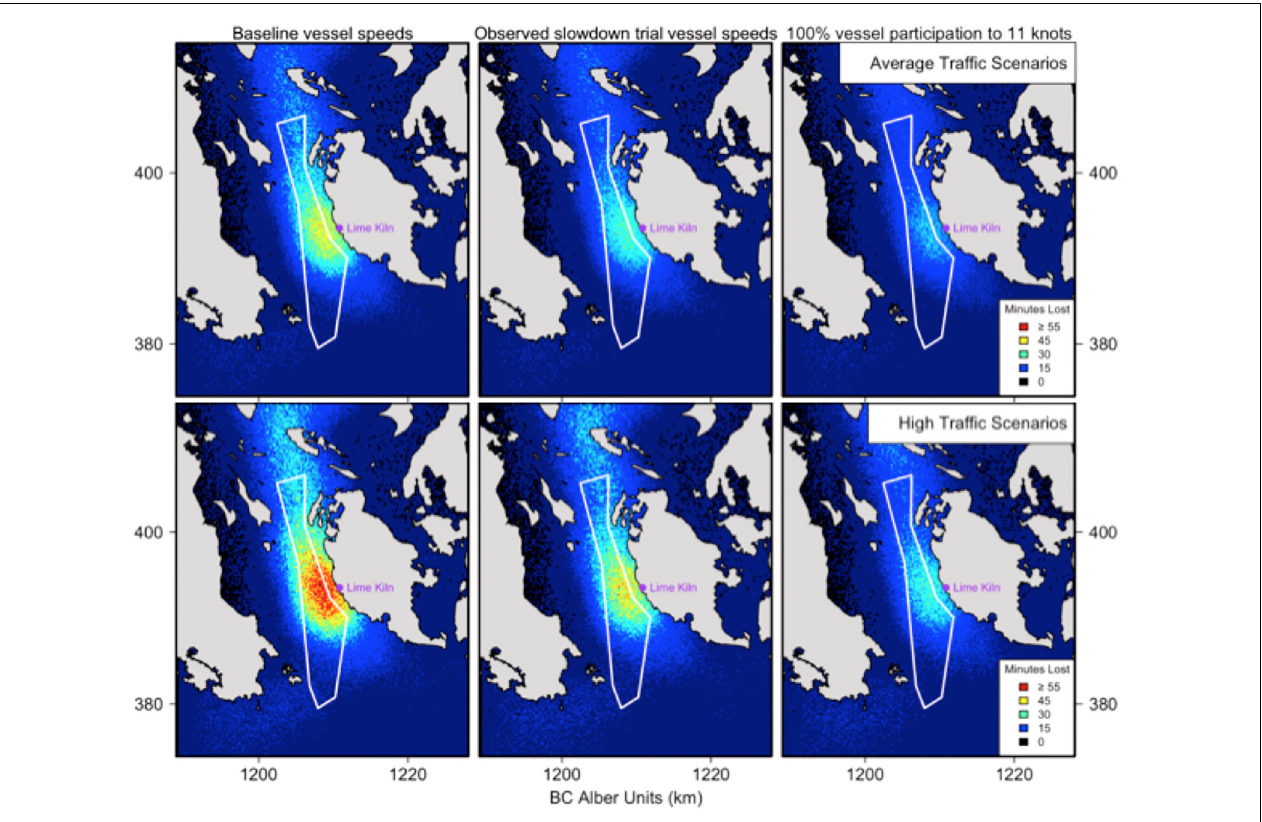
FIGURE 7 | Results of the SRKW noise-exposure model for the Slowdown region accumulated over each of the 288 regional acoustic maps that depict commercial vessel broadband noise over an average traffic day (top three panels, scenarios 1, 2, 3) and high traffic day (bottom three panels, scenarios 4, 5, 6). For a Low BR to occur in the Slowdown region, a SRKW must be present and a commercial vessel must be transiting close enough to the SRKW to elicit a behavioral response. The six panels show the spatially indexed number of minutes of ‘potential lost foraging time’ from a Low severity behavioral responses by a southern resident killer whale. The 11-knot slowdown trial boundary is shown in